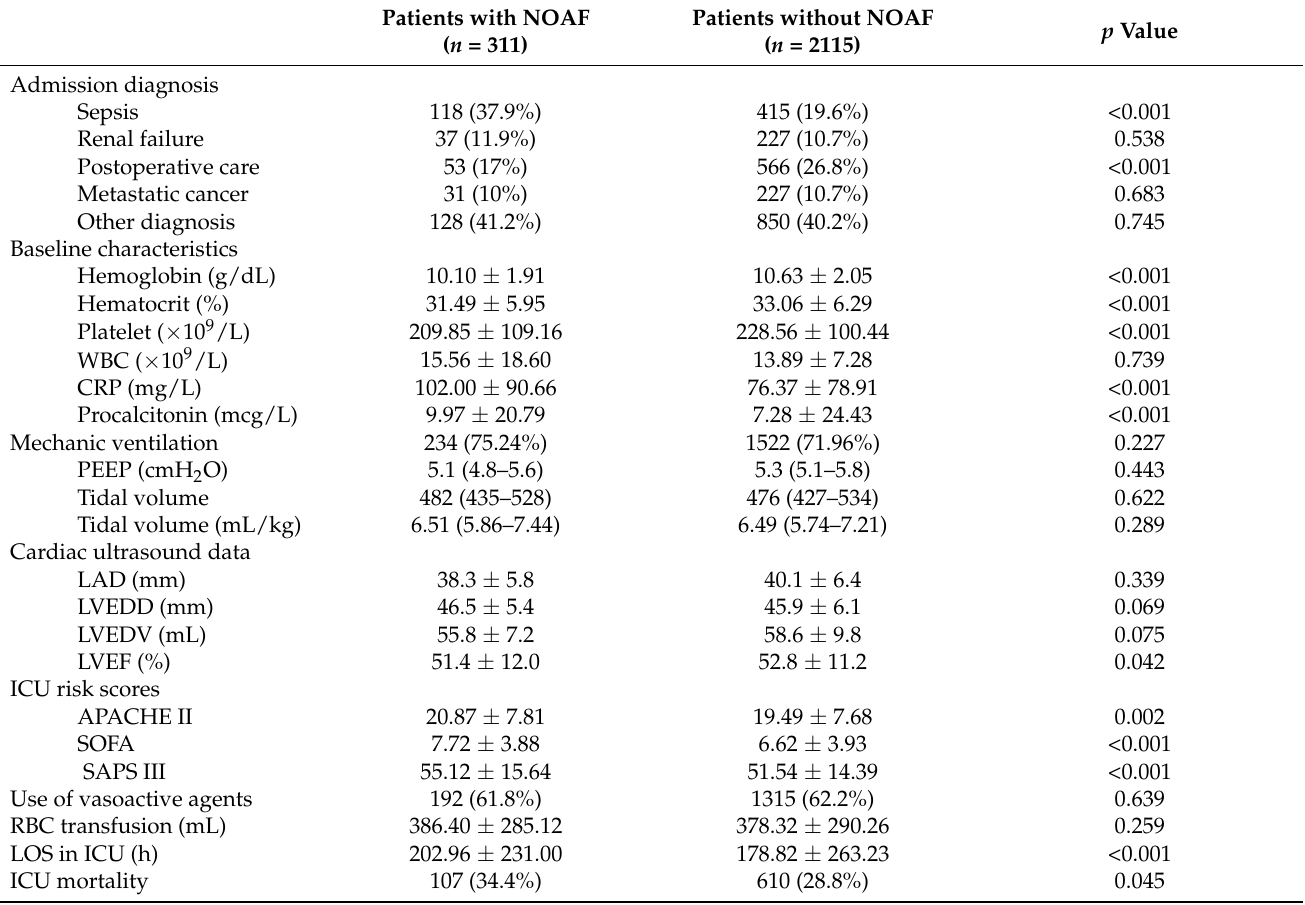
Table 3. Comparison of the medical and laboratory characteristics of patients diagnosed with NOAF.